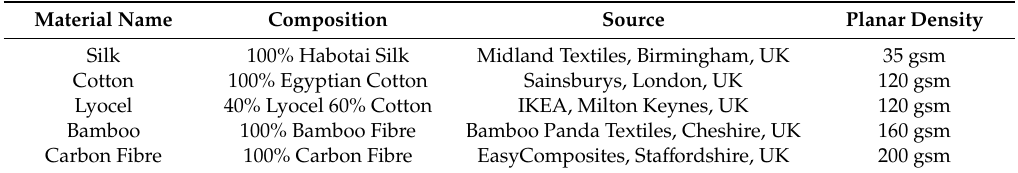
Table 1. Details of matrix materials